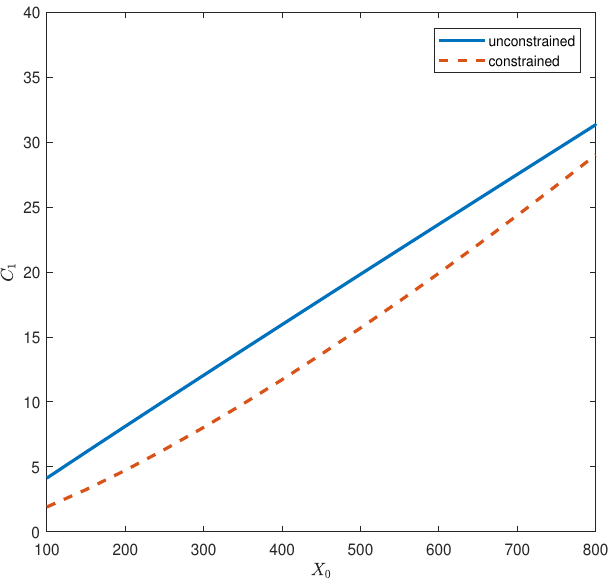
Figure 7. Optimal consumption C at time 1 as a function of initial wealth X 0